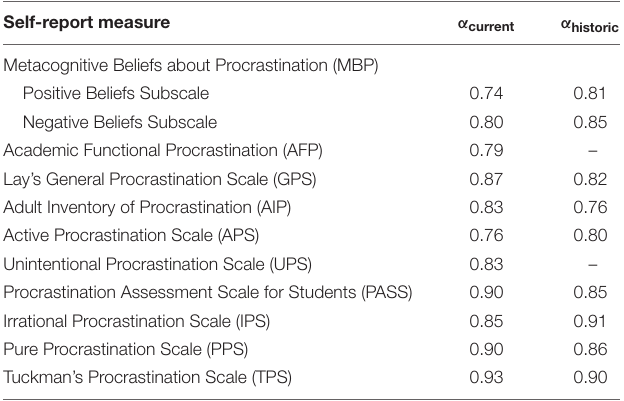
TABLE 2 | Current and historic measures of reliability for self-report procrastination assessments.